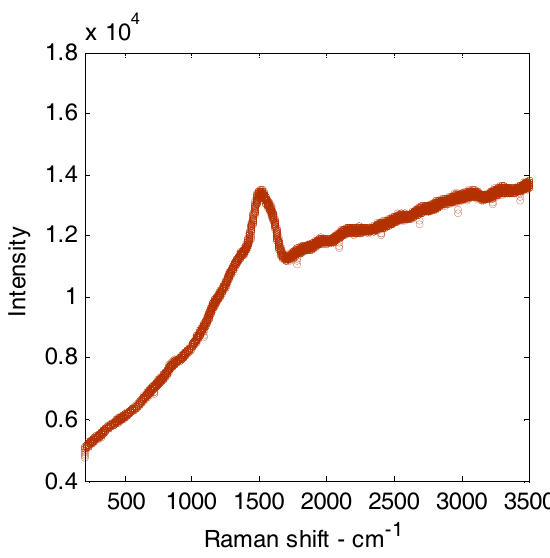
Figure 11. A typical Raman spectrum for a film deposited for 15 s at 200 μ m gap length, 6.6 sccm C 2 H 2 flow rate, 80 kPa inlet pressure, and 1000 V source voltage.